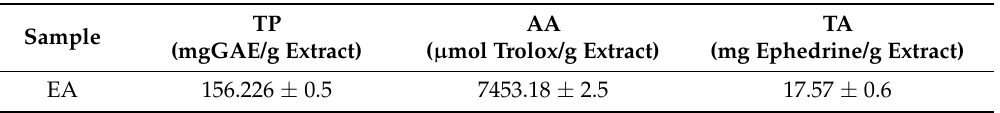
Table 1. The total phenolic content (TP), antioxidant activity (AA), and total alkaloids (TA) of the hydroalcoholic extract of the aerial part of Ephedra alata Decne. (EA).